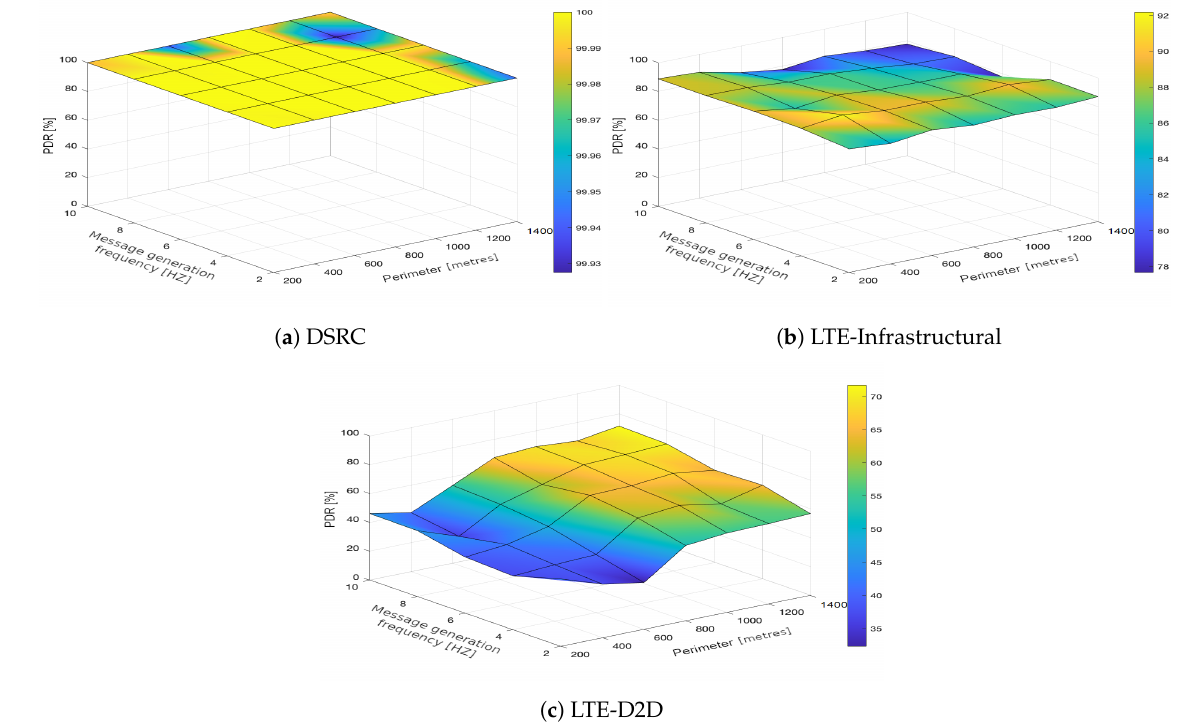
Figure 3. Packet delivery ratio obtained for the traffic intensity of 500 vehicles per